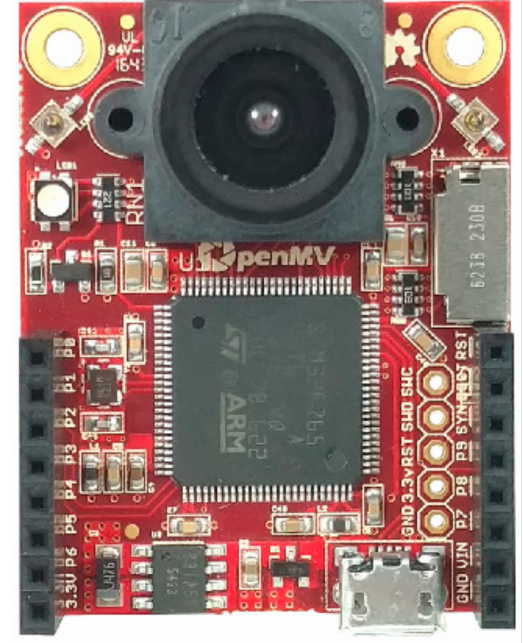
Figure 1. The OpenMV Cam H7